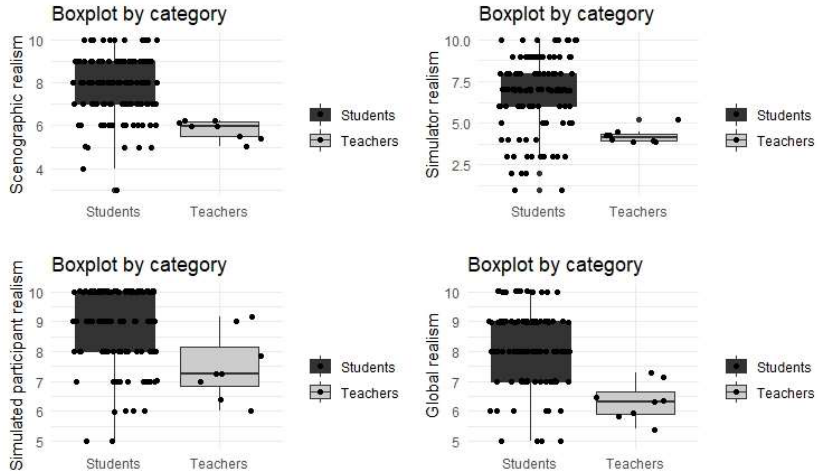
Figure 4 . Box plot of realism as perceived by students and teachers.